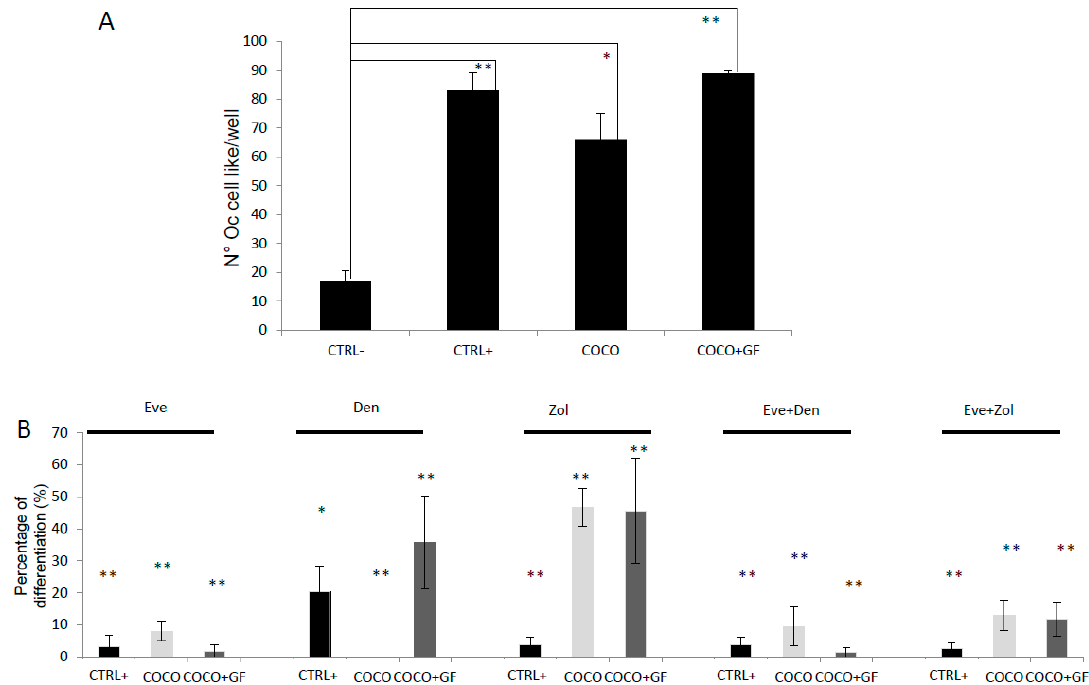
Figure 6. Osteoclastogenesis induced by MCF7 and response to drugs. ( A ) Osteoclastogenesis assay with direct COCO of MCF7; we performed Bonferroni Test obtaining significance in the following comparisons: CTRL − vs. DM: p = 0.007; CTRL − vs. COCO: p = 0.027; CTRL − COCO + GF: p = 0.007; ( B ) Drug effect on osteoclastogenesis; percentage of differentiation with respect to untreated samples after Eve and other bone-targeted drugs administration; Anova analysis and Bonferroni Test were performed when appropriate; in all conditions (CTRL+, COCO; COCO + GF) a significant decrease